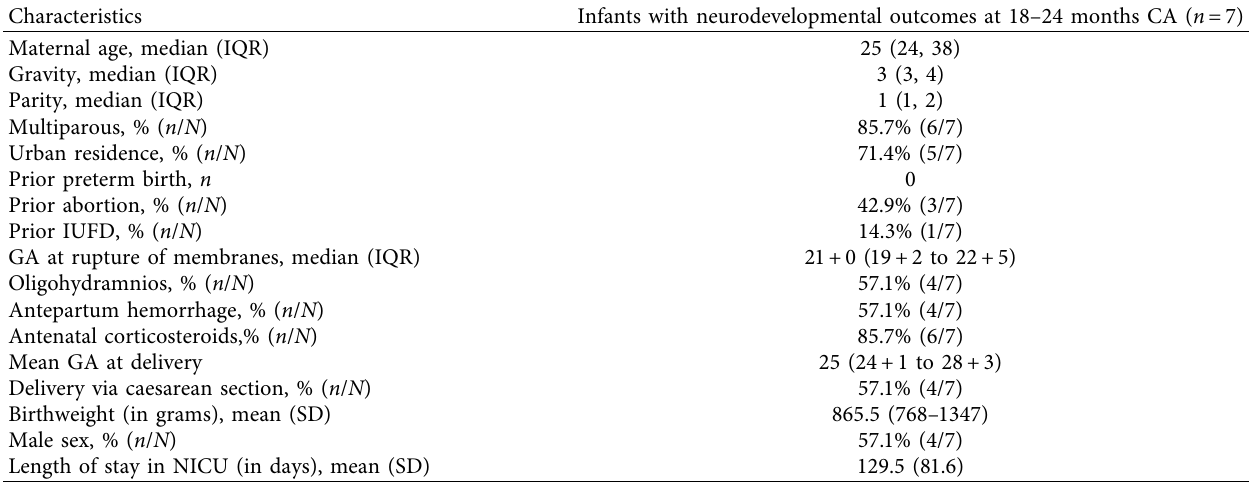
Table 1: Pregnancy characteristics of survivors of pPPROM attending neonatal clinic follow-up at 18–24 months CA. Characteristics